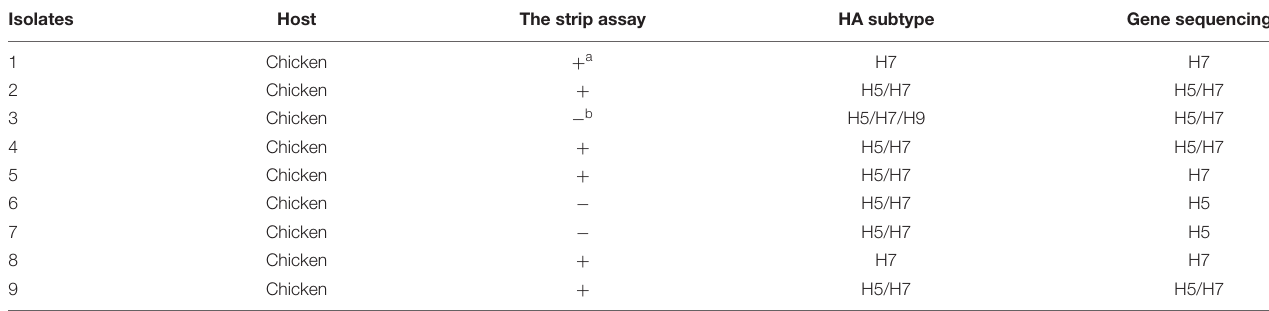
FIGURE 6 | Use of the strip for detecting trachea swabs (A) , cloacal swabes (B) , and lung samples (C) from H7N9 AIV experimentally infected chickens. A-1, B-1, and C-1: H7 positive AIV, A-2: trachea swab sample contained 2.5 log 10 EID 50 , A-3: trachea swab sample contained 1.5 log 10 EID 50 , B-2: cloacal swab sample contained 2.5 log 10 EID 50 , B-3: trachea swab sample contained 1.5 log 10 EID 50 , C-2: lung sample contained 3.5 log 10 EID 50 , C-3: lung sample contained 2.5 log 10 EID 50 , and C-4: lung sample contained 1.5 log 10 EID 50 . TABLE 4 | Results from cloacal swab samples from LPM using the strip assay, isolation, and gene sequencing. Isolates The strip assay HA subtype Gene sequencing